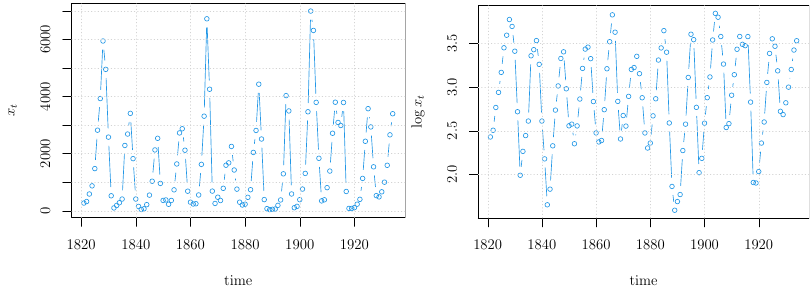
Figure 1 – Time series of the Canadian lynx time series, from 1821 to 1934. (Left) raw time series. (Right) log-transformed